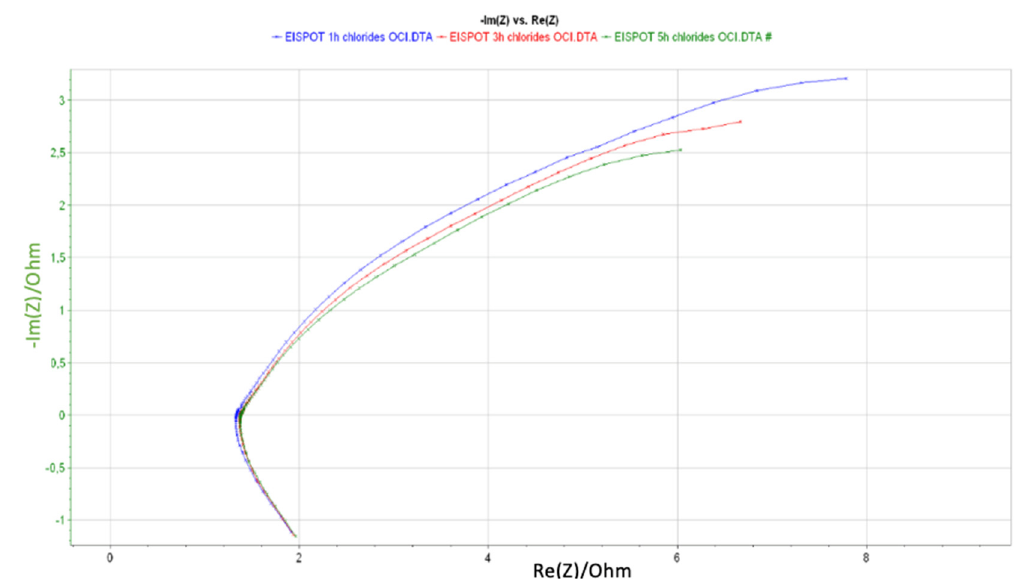
Figure 4. Micrographs showing a top view (left) and a cross section (right) of OC4 immersed in ternary chloride molten salt for 8 h at 720 °C; Energy dispersive X-ray (EDX) analysis on top.